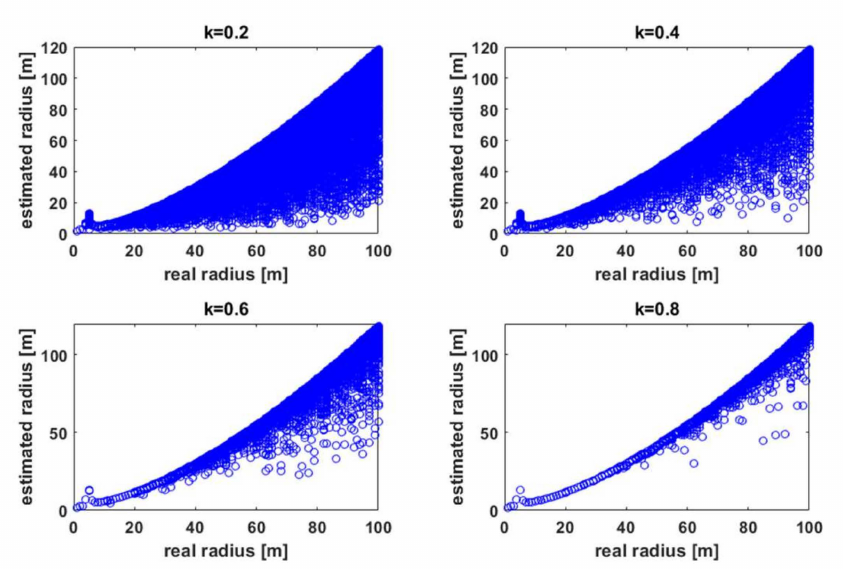
Figure 10. Values of the distance estimated as a function of the real distance for different values of the k -factor.